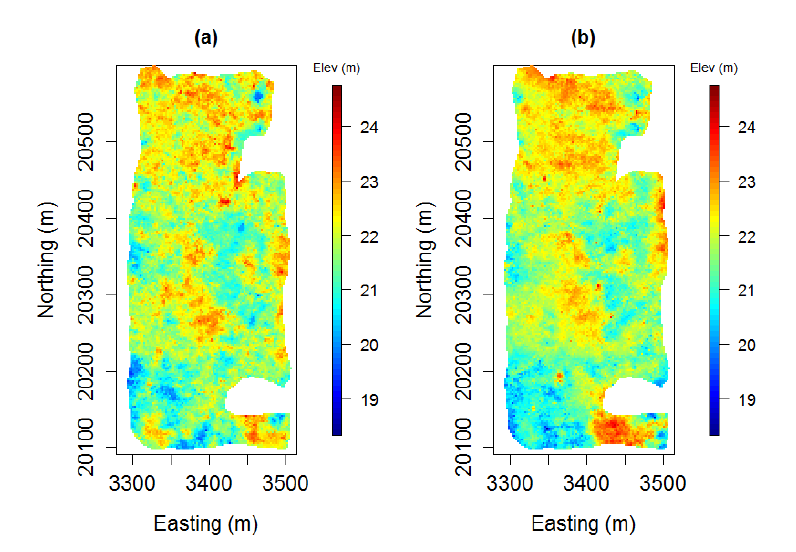
Figure 4. Realisations produced with ( a ) the initial parameters and ( b ) final